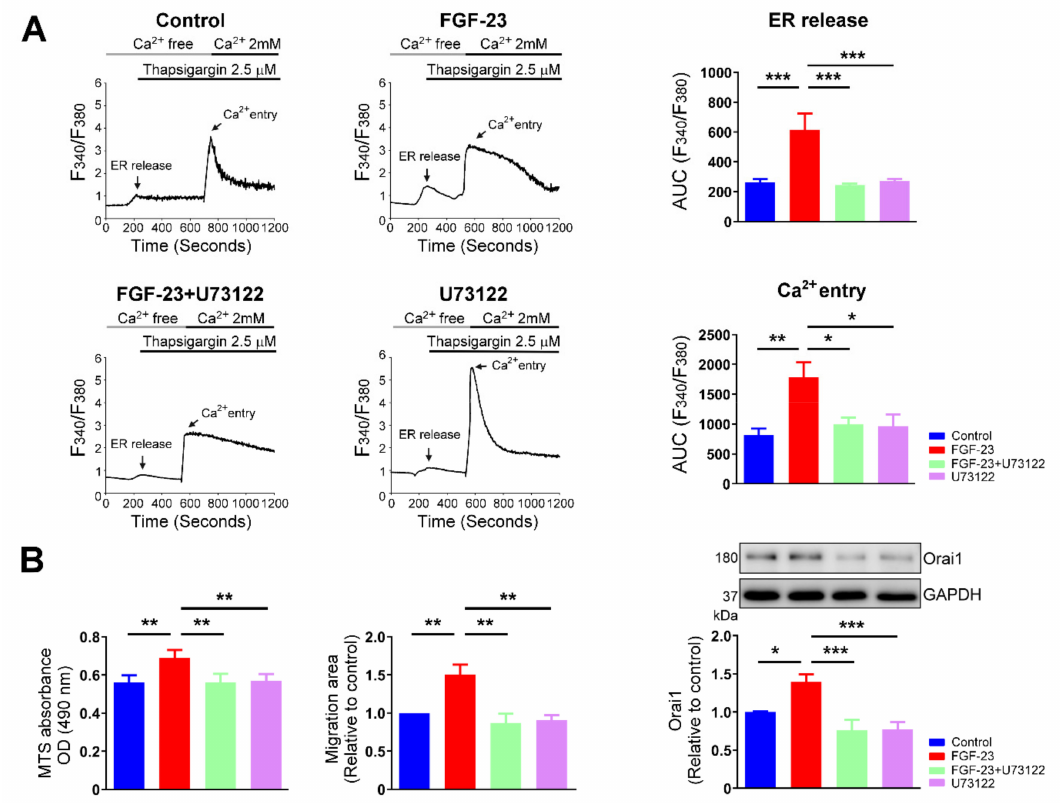
Figure 8. Phospholipase C (PLC) signaling involved in fibroblast growth factor (FGF)-23 stimulates cardiac fibroblast proliferation and migration. ( A ) Representative fura-2 based intracellular calcium (Ca 2+ ) tracings (left panel) and average changes in Ca 2+ concentrations (right panel, n = 12 cells) from control, FGF-23 (25 ng/mL for 48 h)-treated, U73122 (a PLC inhibitor, 1 µ M for 48 h)-treated and FGF-23 combined with U73122-treated cardiac fibroblasts. Cells were initially incubated in Ca 2+ -free buffer. The ER Ca 2+ release and extracellular Ca 2+ entry were induced after addition of 2.5 µ M thapsigargin and subsequently 2 mM Ca 2+ to the calcium free bath solution, respectively. The average Ca 2+ changes were quantified as the area under the curve (AUC) values of fluorescence intensities (F340/F380) corresponding to ER Ca 2+ release and extracellular Ca 2+ entry. Fura-2 fluorescent signals were recorded from an individual cardiac fibroblast. Thus, the increases of Ca 2+ levels in cardiac fibroblasts following exposure to FGF-23 should not be caused by there being more cells present. ( B ) Average data of cardiac fibroblast proliferation (left panel, n = 5), migration (middle panel, n = 5), and representative immunoblots and average data of calcium release-activated calcium channel protein 1 (Orai1) expression (right panel, n = 6) from control and FGF-23 (25 ng/mL for 48 h)-treated cardiac fibroblasts without and with U73122 (1 µ M) treatment. * p < 0.05, ** p < 0.01, *** p <